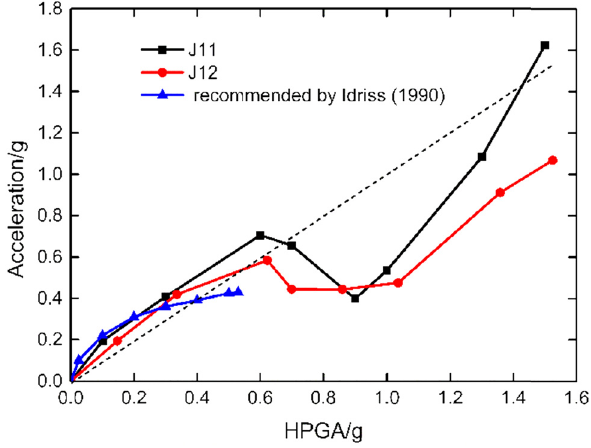
Figure 11: Curves of peak acceleration at J11 and J12 of dam crest vs variable HPGA.